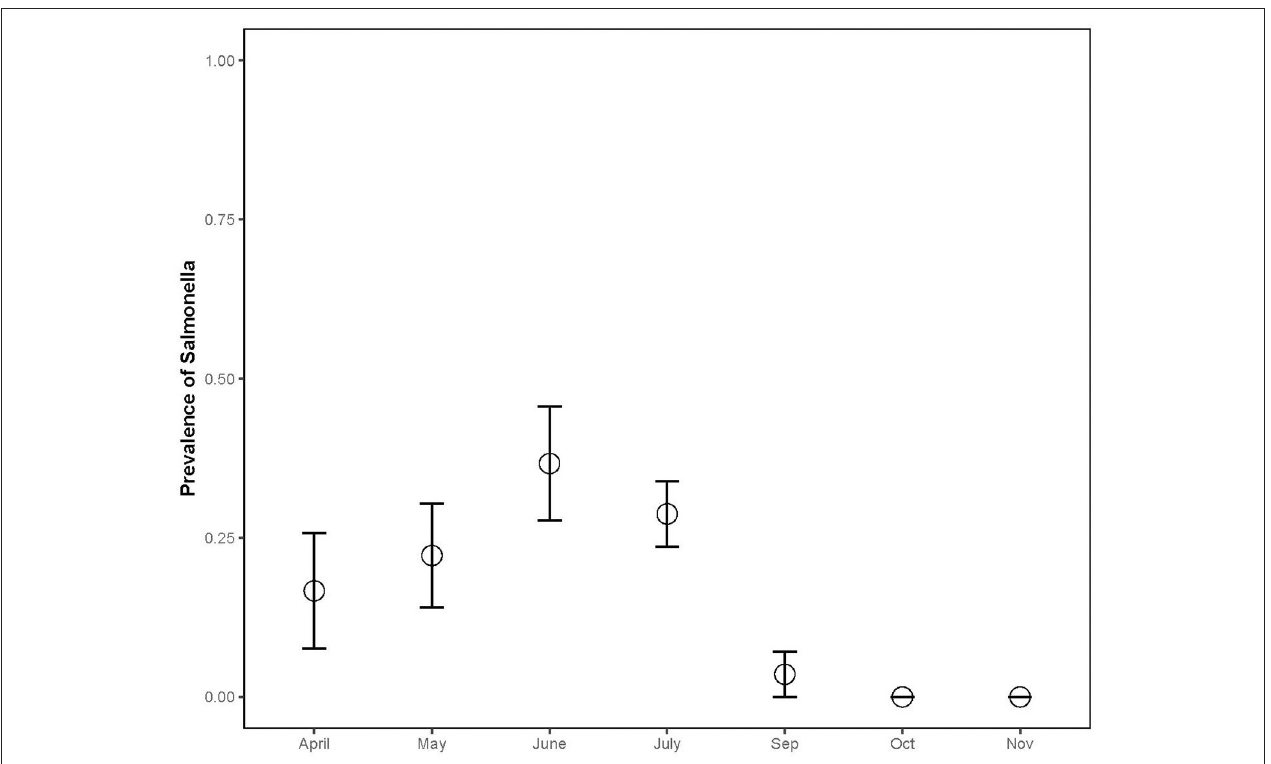
FIGURE 4 | Salmonella prevalence of aquatic turtle species varied by sampling month